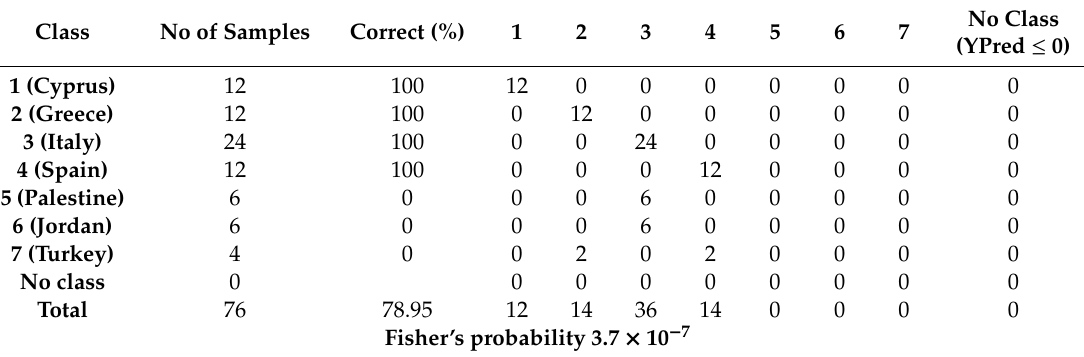
Figure 5. Permutation plot of the PLS model (R 2 = 0.95%, Q 2 = 0.98). Table 3. Misclassification table for the PLS model.